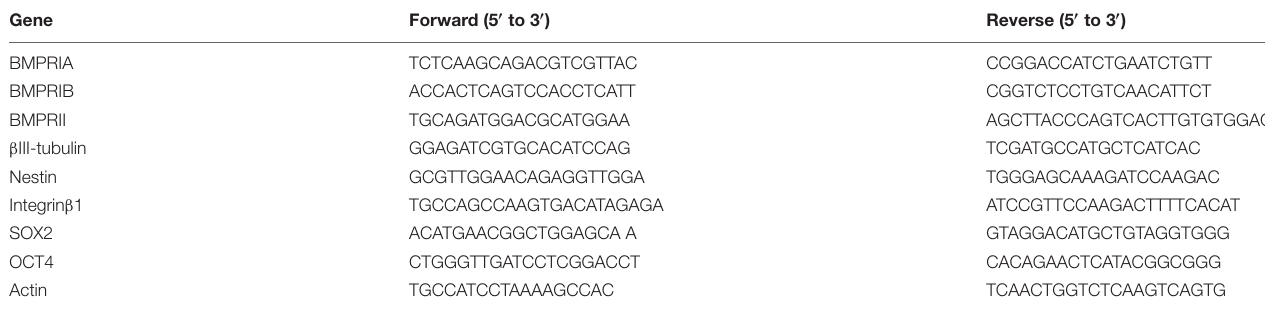
TABLE 1 | Primer sequences for